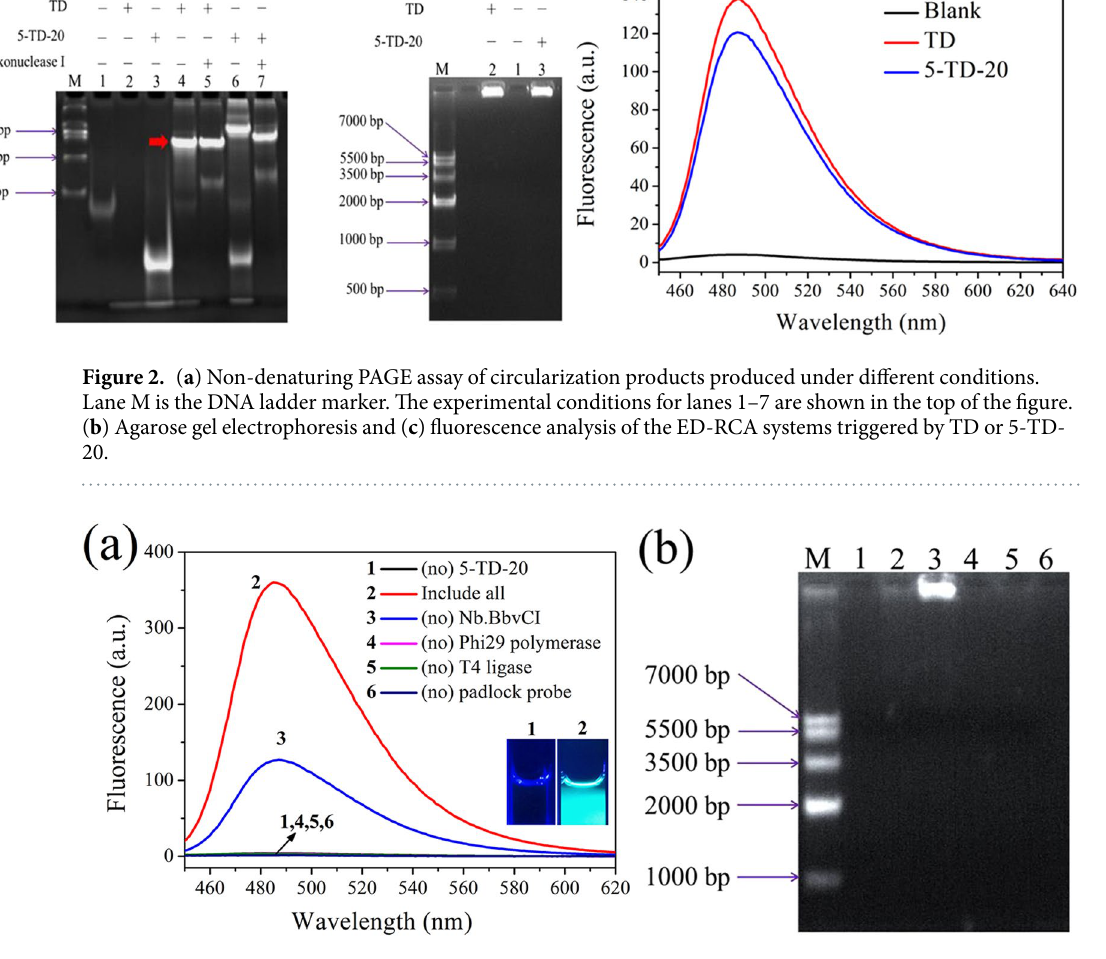
Figure 3. ( a ) Fluorescence and ( b ) agarose gel electrophoresis assay of 5-TD-20-triggered ED-RCA reaction systems. 1 nM of 5-TD-20 were used in fluorescence and electrophoresis assays. The insert in ( a ) shows the photographed images of the exponential RCA systems without or with 5-TD-20